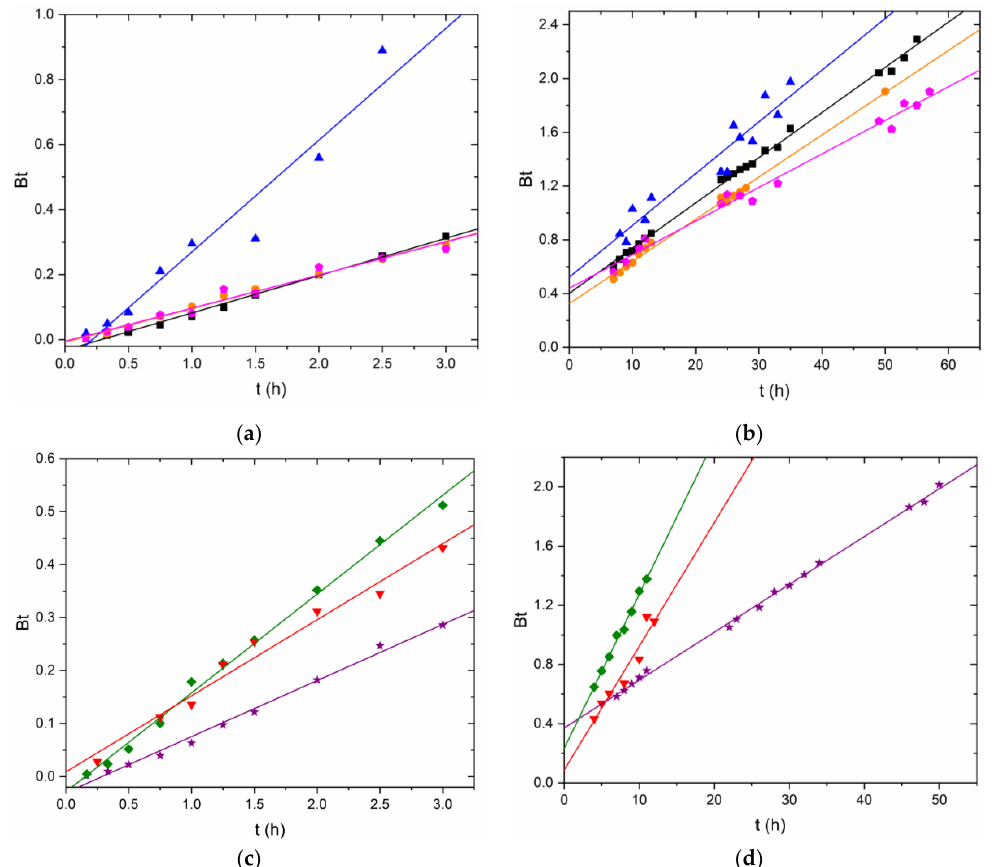
Figure 7. Linearized kinetics of Cr(VI) removal by GSLP-Fe(0) using the Boyd model. ( a ) First linear part of the kinetics using GSLP-Fe(0) D3. ( b ) Second linear part of the kinetics using GSLP-Fe(0) D3. ( c ) First linear part of the kinetics using GSLP-Fe(0) D2. ( d ) Second linear part of the kinetics using GSLP-Fe(0) D2. All experiments were acidified using HCl 4M. ( ■ ) pH ≈ 1.2, initial Cr(VI) concentration: 50 mg·L − 1 ; ( ● ) pH ≈ 0.8, initial Cr(VI) concentration: 50 mg·L − 1 ; ( ⬟ ) pH ≈ 0.8, initial Cr(VI) concentration: 75 mg·L − 1 ; ( ▲ ) pH ≈ 0.8, initial Cr(VI) concentration : 100 mg·L − 1 . ( ★ ) pH ≈ 1.2, initial Cr(VI) concentration: 50 mg·L − 1 ; ( ♦ ) pH ≈ 0.8, initial Cr(VI) concentration : 50 mg·L − 1 ; ( ▼ ) pH ≈ 0.8, initial Cr(VI) concentration: 75 mg·L − 1 .